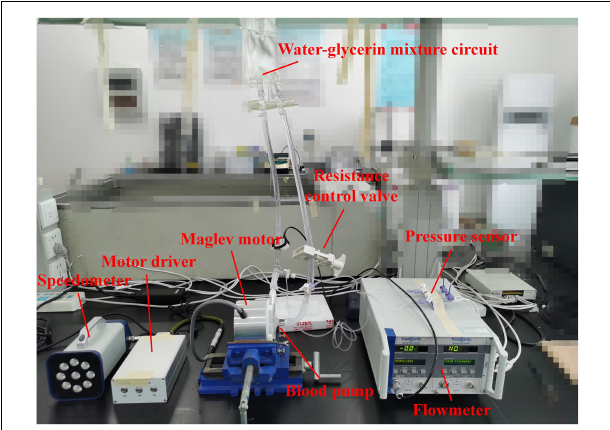
FIGURE 2 | Schematic of hydraulic experiment.